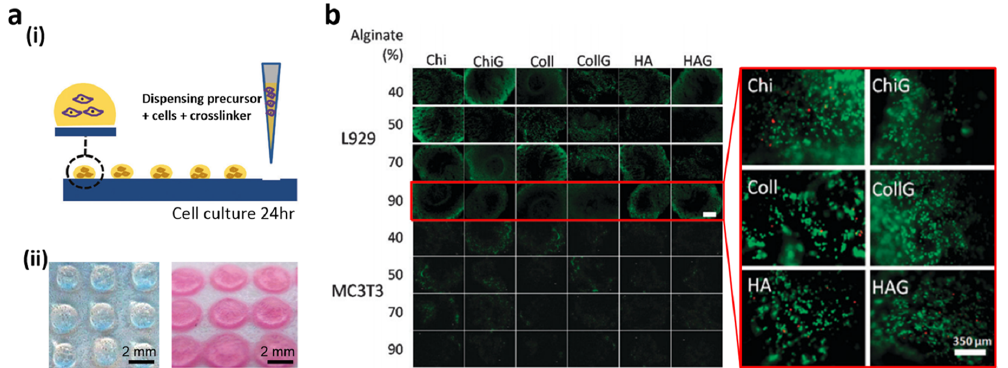
Figure 8. ( a ) ( i ) Three ‐ dimensional (3D) hydrogel array on hydrophilic patterned spots; ( ii ) The images before and after 24 h of immersion in culture medium of alginate based 3D hydrogels; ( b ) Fluorescent microscopy images of live (green)/dead (red) cells in the 24 different hydrogels after 24 h of cell culture. Reproduced from [120] with permission by Royal Society of Chemistry, Copyright